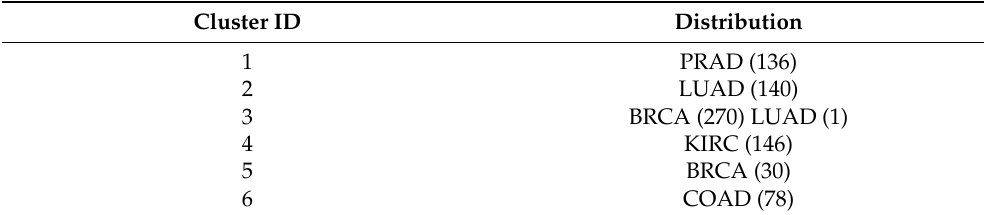
Table 1. The distribution of the posterior TIP cluster assignments. The number in parenthesis is the number of subjects (e.g., gene expression samples) for one of the five cancer types.